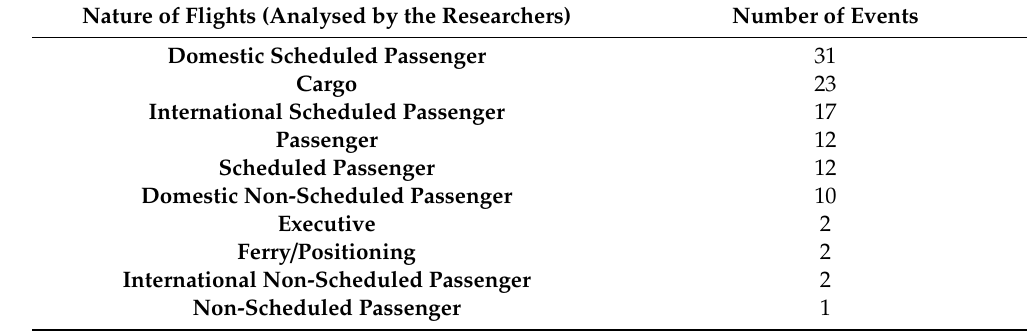
Table 1. Breakdown of Events by Nature of the Flights (the full list of categories for the ‘nature of flights’ used by the Aviation Safety Network can be accessed @ https: // aviation-safety.net / about / ASN- standards.doc).